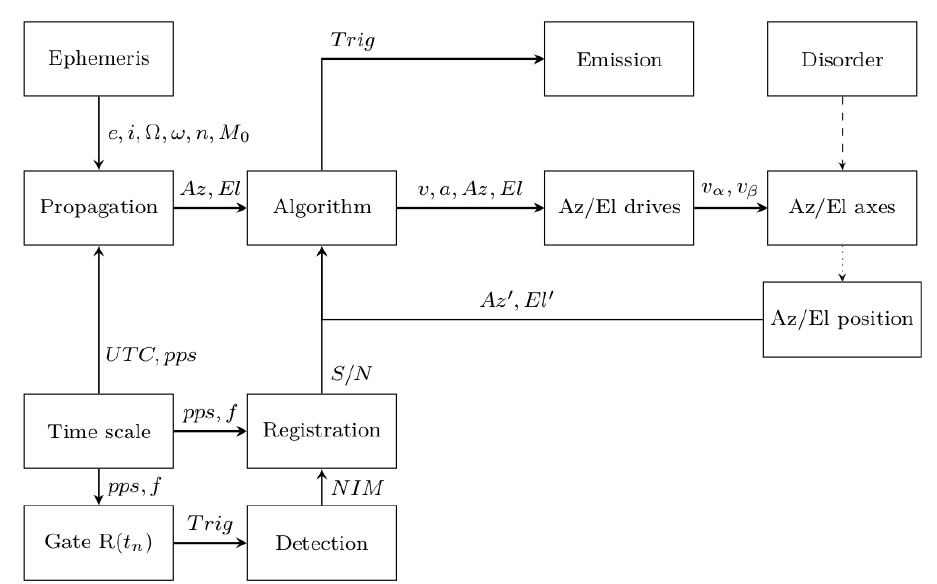
Figure 7. Block diagram of the active control correction algorithm based on ephemeris data and photon